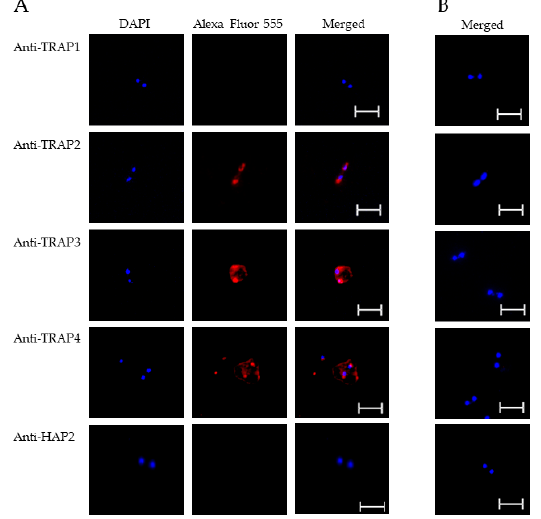
Figure 2. Evaluation of TRAP protein expression by B. bovis blood stages using a fixed immunofluorescence assay incubated with anti-TRAP 1, 2, 3, 4 or HAP2. Panels are ( A ) immune and ( B ) pre-immune rabbit serum. Blue indicates DAPI stained DNA and red indicates anti-rabbit IgG Alexa Fluor 555 reactivity. Scale bar: 5 µm.